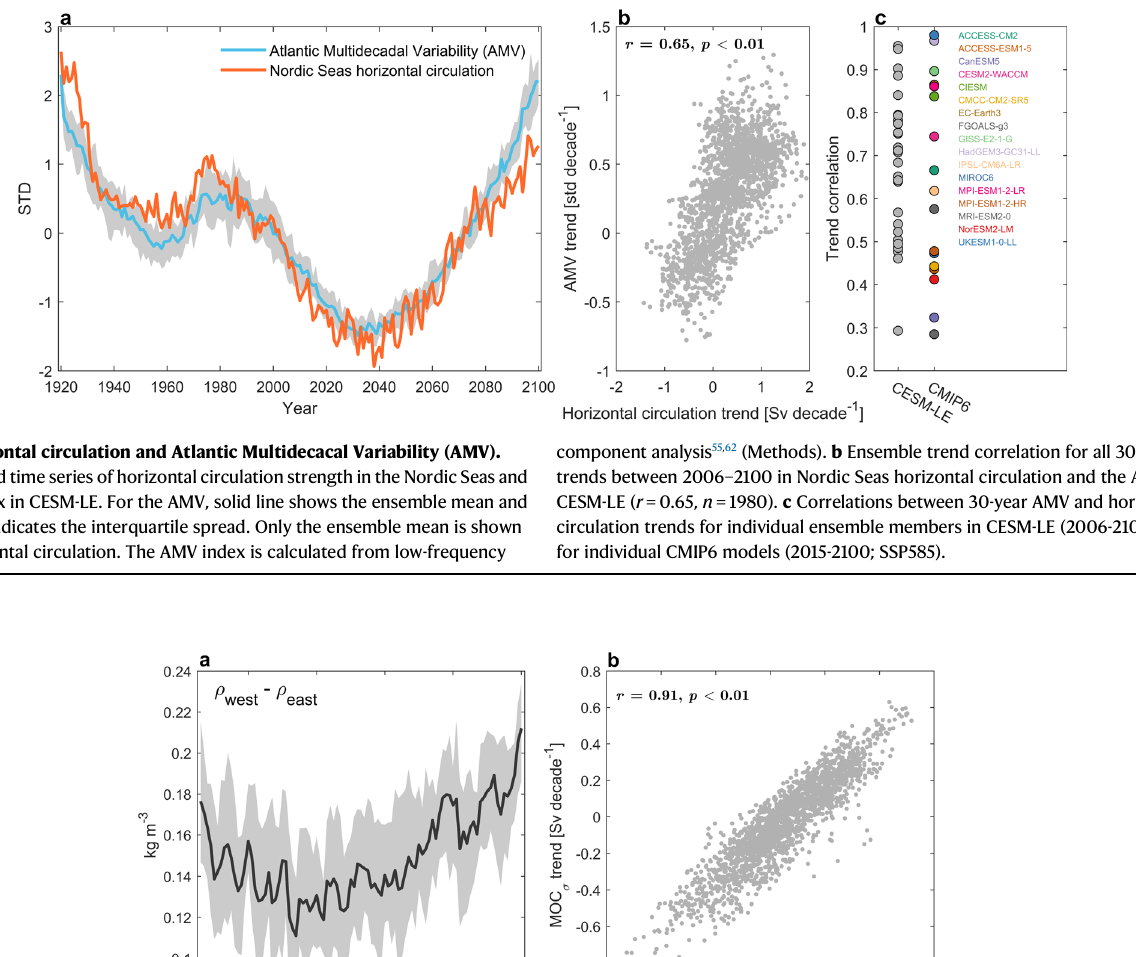
interquartile spread. b Ensemble trend correlation for all 30-year trends between 2006 – 2100 in Nordic Seas overturning strength (MOC σ ) and horizontal density gradient ( r =0.91, n =1980).